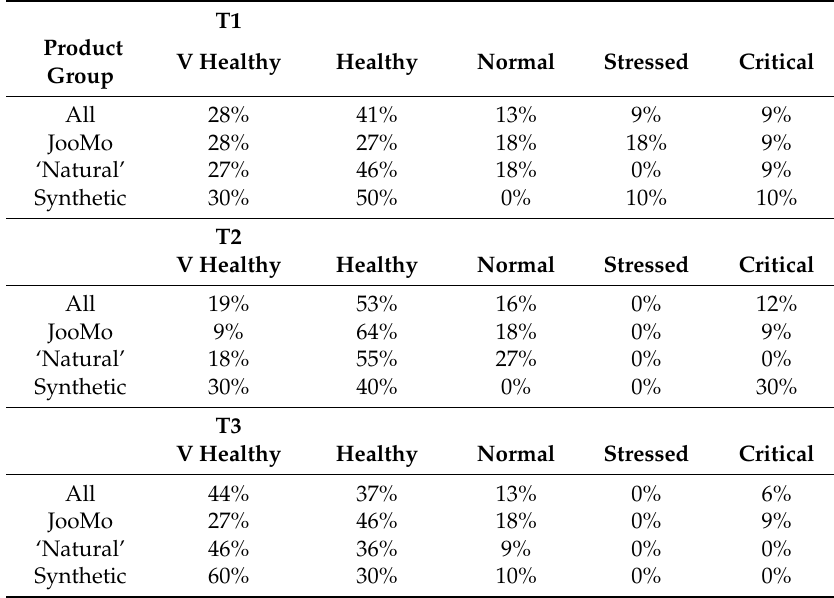
Table A1. Comparison of the percentage of different skin types throughout all study subjects based on the epidermal water loss measured with a Tewameter before product use (=T1), after 2 weeks of product use (=T2) and after 4 weeks of product use (=T3).